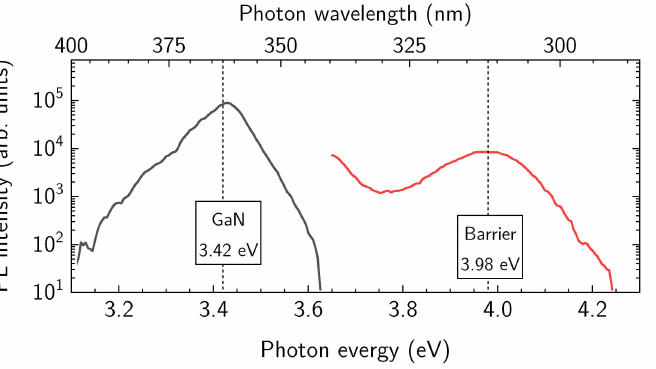
Figure 6. PL spectra of the heterostructure measured using different excitation wavelength and peak power density of 300 nm and 200 kW/cm 2 (black line) and 250 nm and 3 MW/cm 2 (red line),